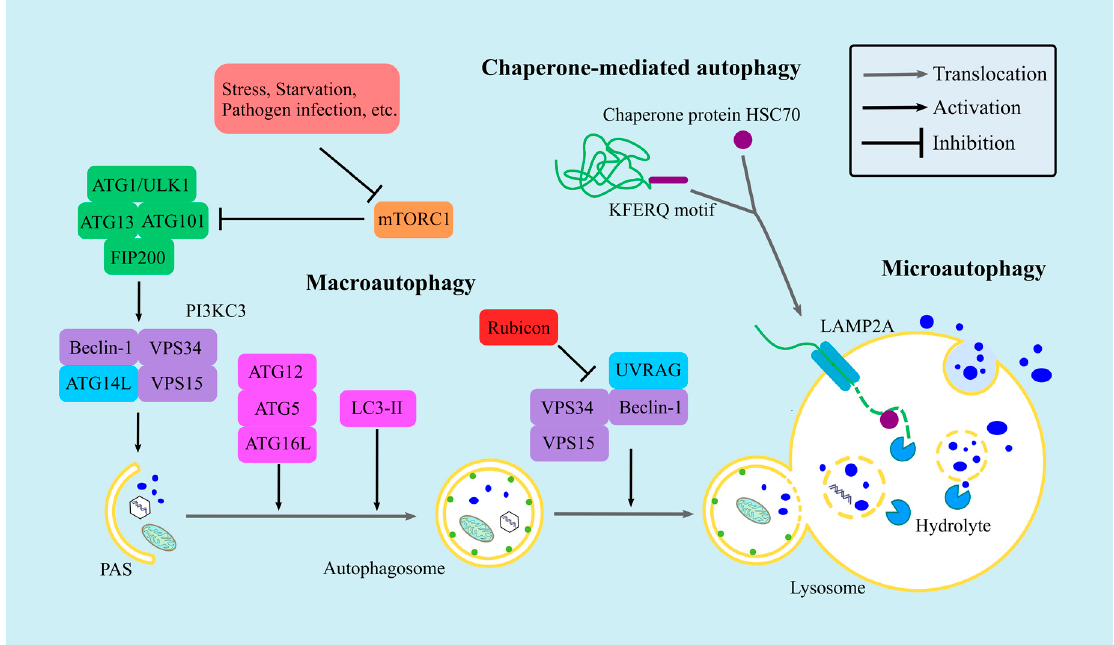
Figure 1. The types of autophagy. There are three autophagic routes: chaperone-mediated autophagy (CMA), microautophagy, and macroautophagy. In CMA, the KEFRQ motif of target proteins is recognized and captured by the chaperone protein HSC70. The complexes are then transported into the lysosome via a lysosomal receptor, LAMP2A. In microautophagy, cytosolic contents are sequestered by invagination of the lysosomal membrane, separated, and degraded in the lysosome. Macroautophagy is the dominant autophagic type, which is strictly directed by mTORC1 and several autophagy-related gene (ATG) protein complexes.